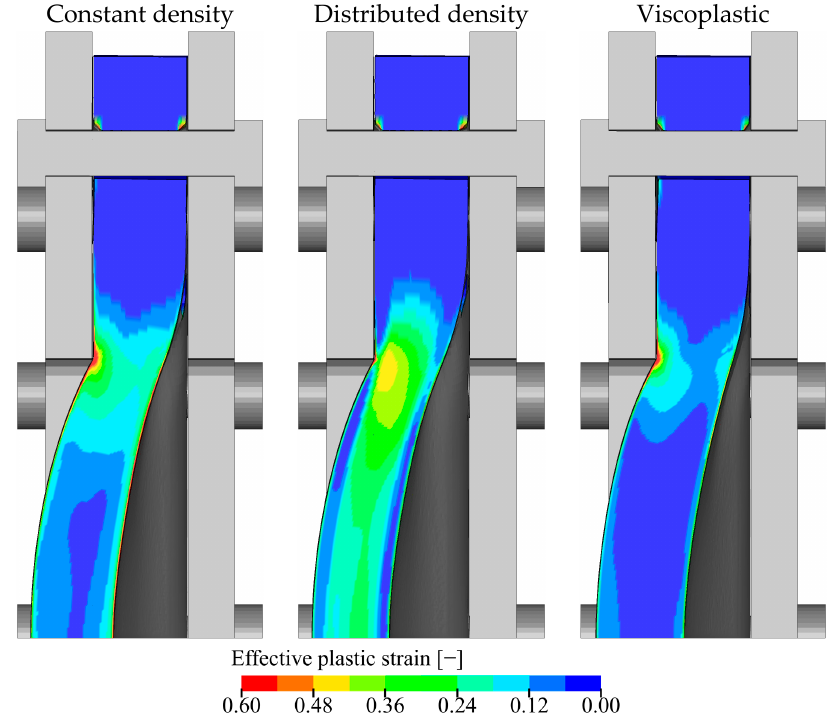
Figure 22. Deformation profiles and plastic strain fields from numerical simulations of test Sw_250_P10.